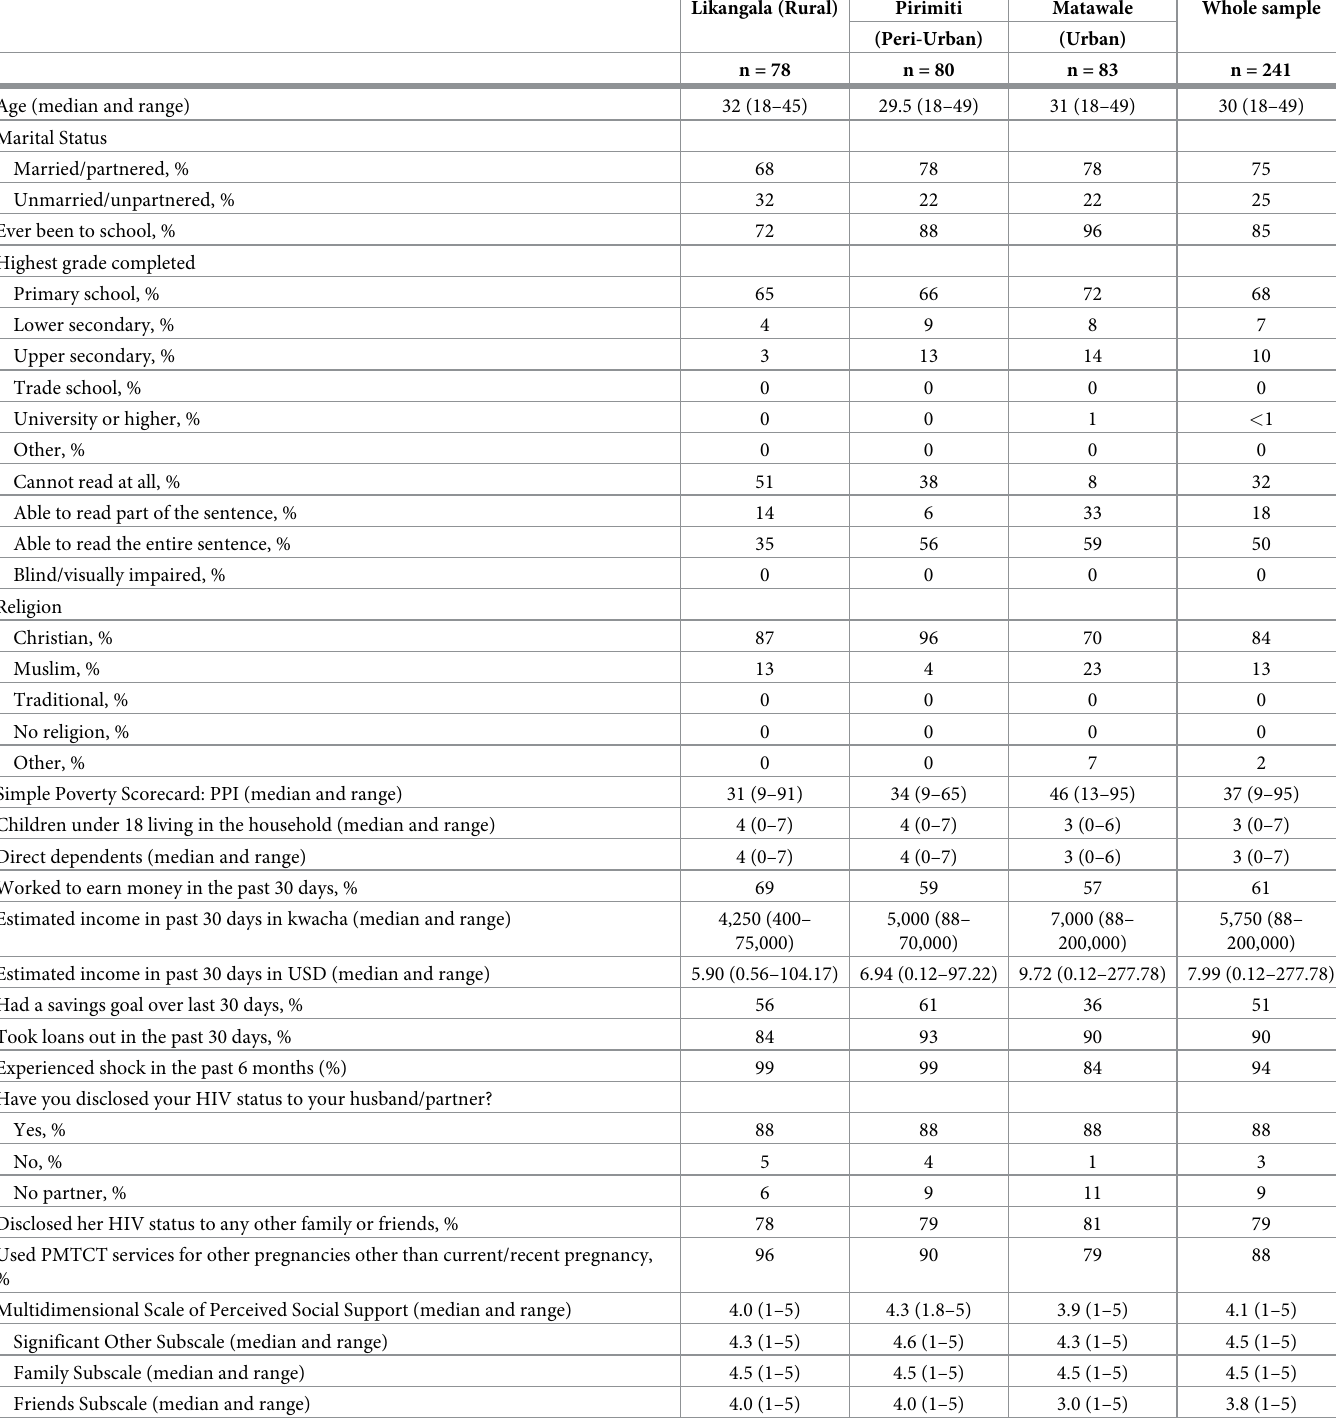
Table 3. Baseline demographics of financial diary participants in Zomba, Malawi in July